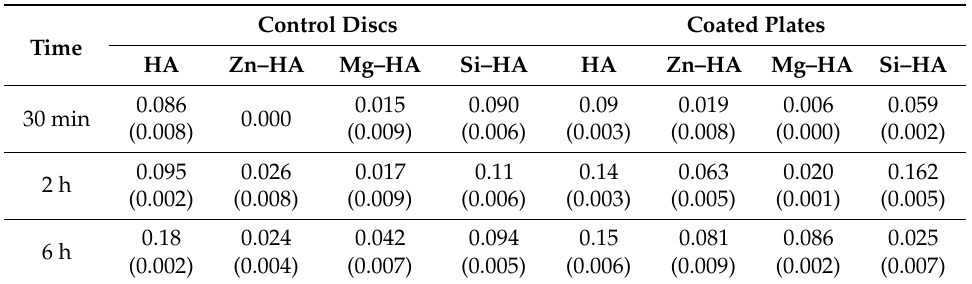
Table 3. Absorbance mean (SD) values for discs and coated HA, Zn–HA, Mg–HA and Si–HA samples at 30 min, 2 h and 6 h of bacterial adhesion.